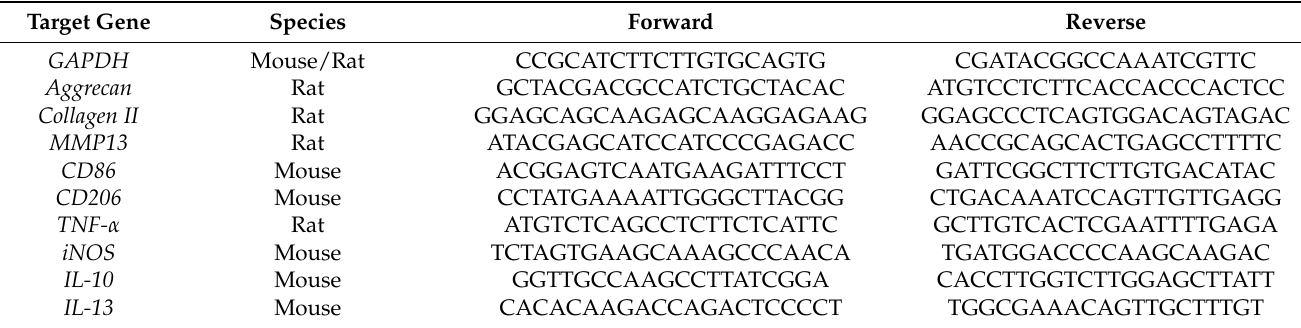
Table 2. Primer sequence of target